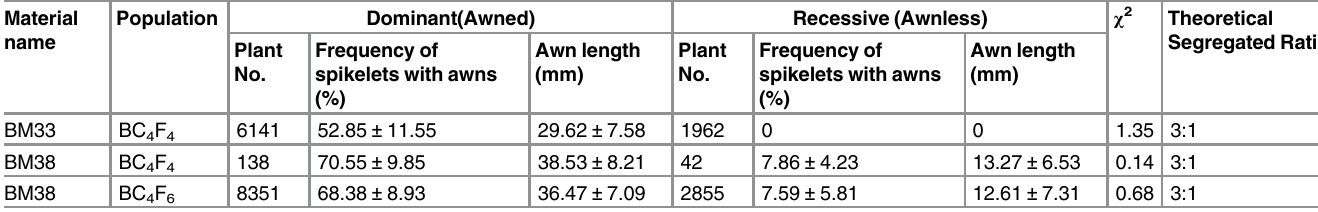
Table 1. Phenotypic and genetic analysis of the BM33 and BM38 NIL